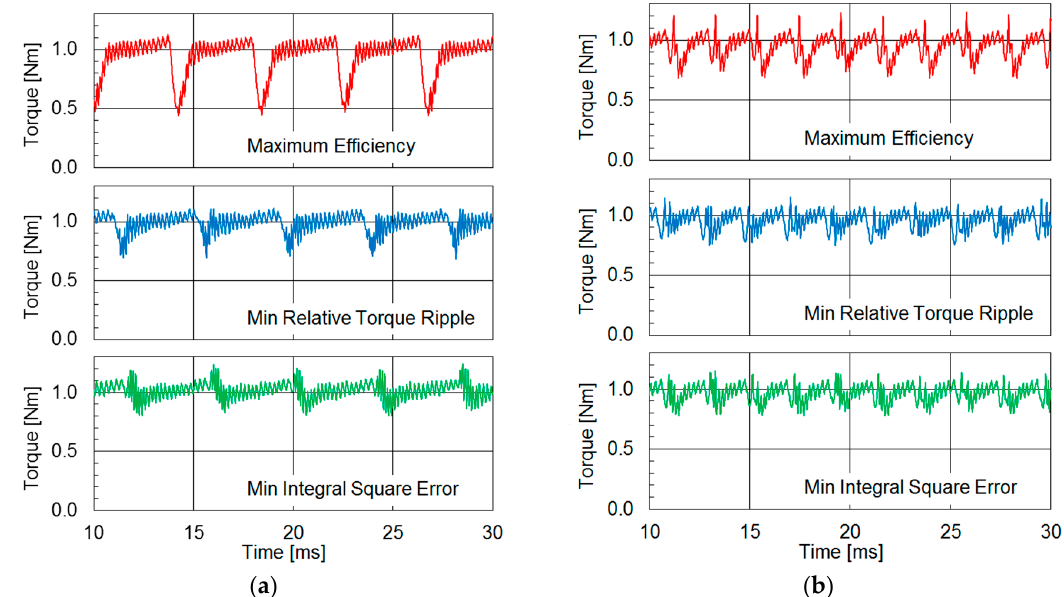
Figure 10. Simulated motor torque for optimal parameter values at load torque 1 Nm: ( a ) speed 600 rpm; ( b ) speed 1200 rpm.